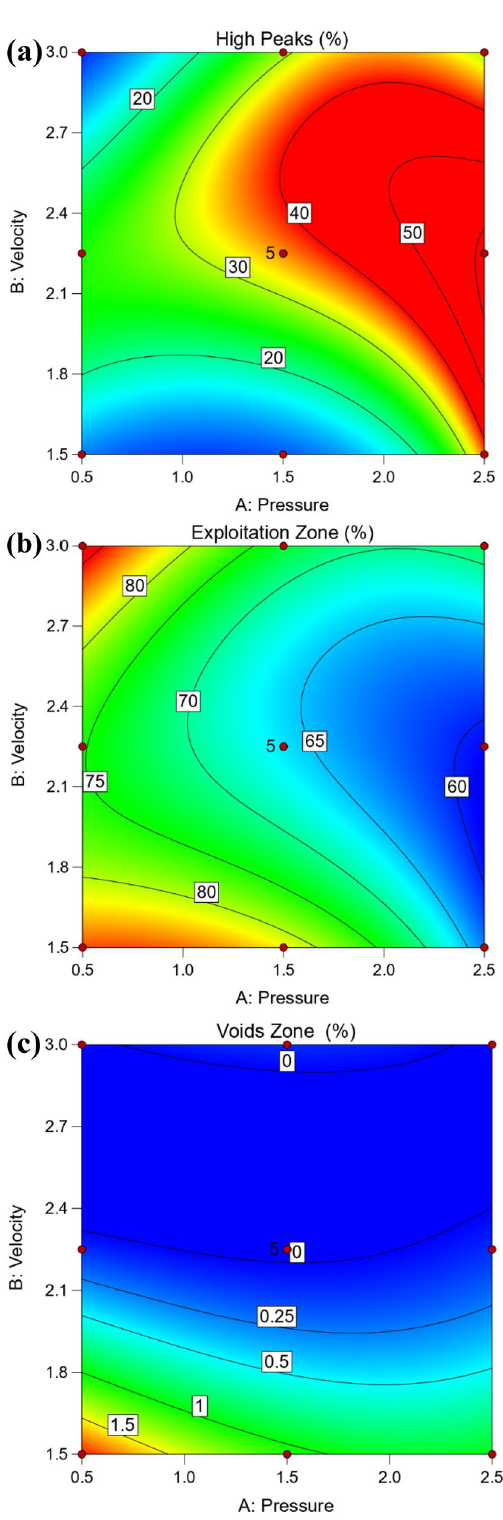
Figure 15. Contour plot of ( a ) high peaks, ( b ) exploitation, and ( c ) voids of QAM f